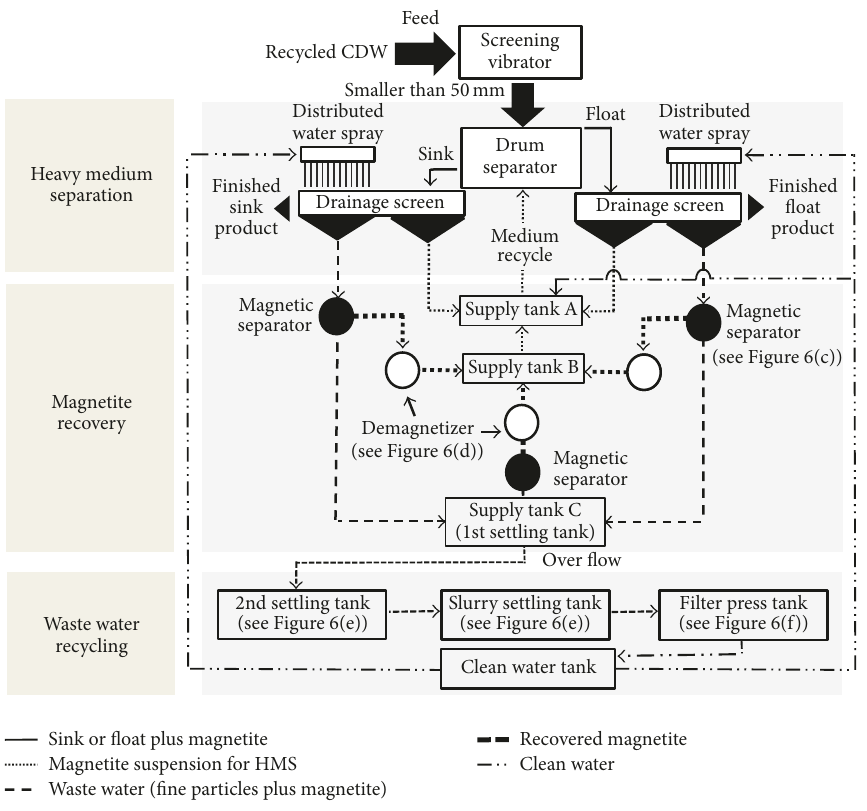
Figure 3: Illustration of the prototype heavy media separation system using Fe 3 O 4 suspension in this study.